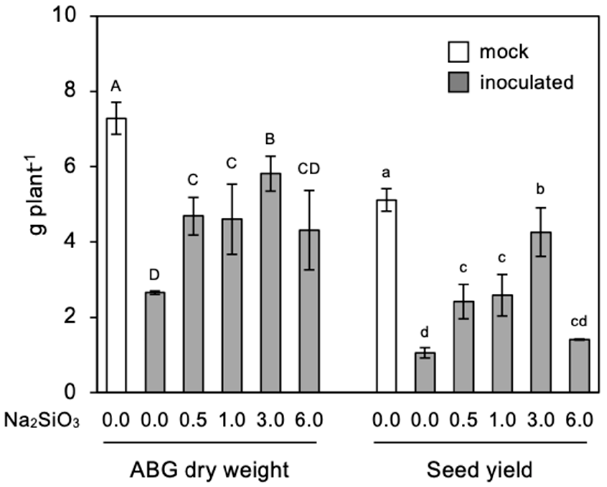
Figure 5. Aboveground DW (ABG dry weight) and seed yield of soybean plants ( n = 12). Different letters (lowercase for 3 WPI, uppercase for 6 WPI) at each sampling time point indicate significant difference ( p < 0.05), as per Tukey’s HSD test.